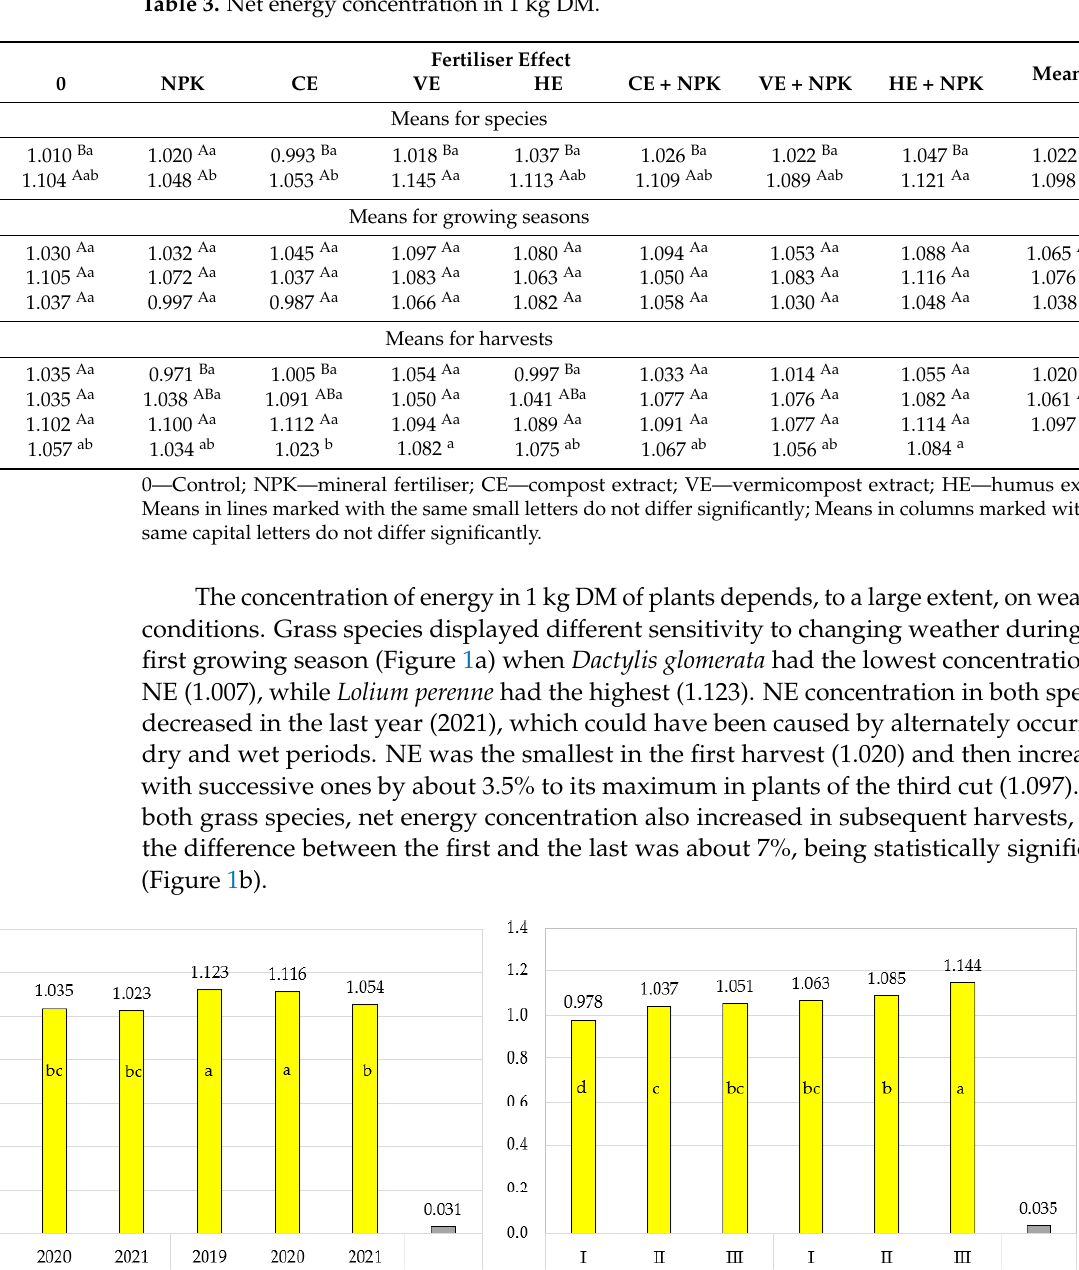
Table 3. Net energy concentration in 1 kg DM.